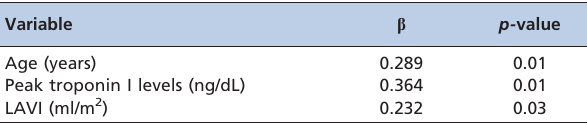
Table 5 - Variables associated with NT-proANP levels in patients with STEMI (Nagelkerke R 2 = 0.247 for the multivariate regression